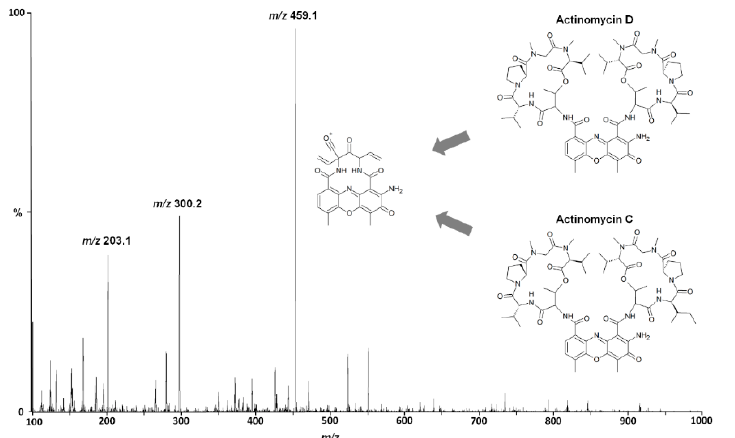
Figure 1. Positive product spectrum (MS/MS) of the [M+H] + signal (m/z 1255.6) of actinomycin D in collision-induced decomposition using a collision energy of 62 V. The structures of actinomycin D, actinomycin C, and their monitored common product ion ( m/z 459.1) are additionally depicted. For details on the product ions and fragmentation scheme of actinomycin D, the reader is referred to the work of Thomas and co-workers